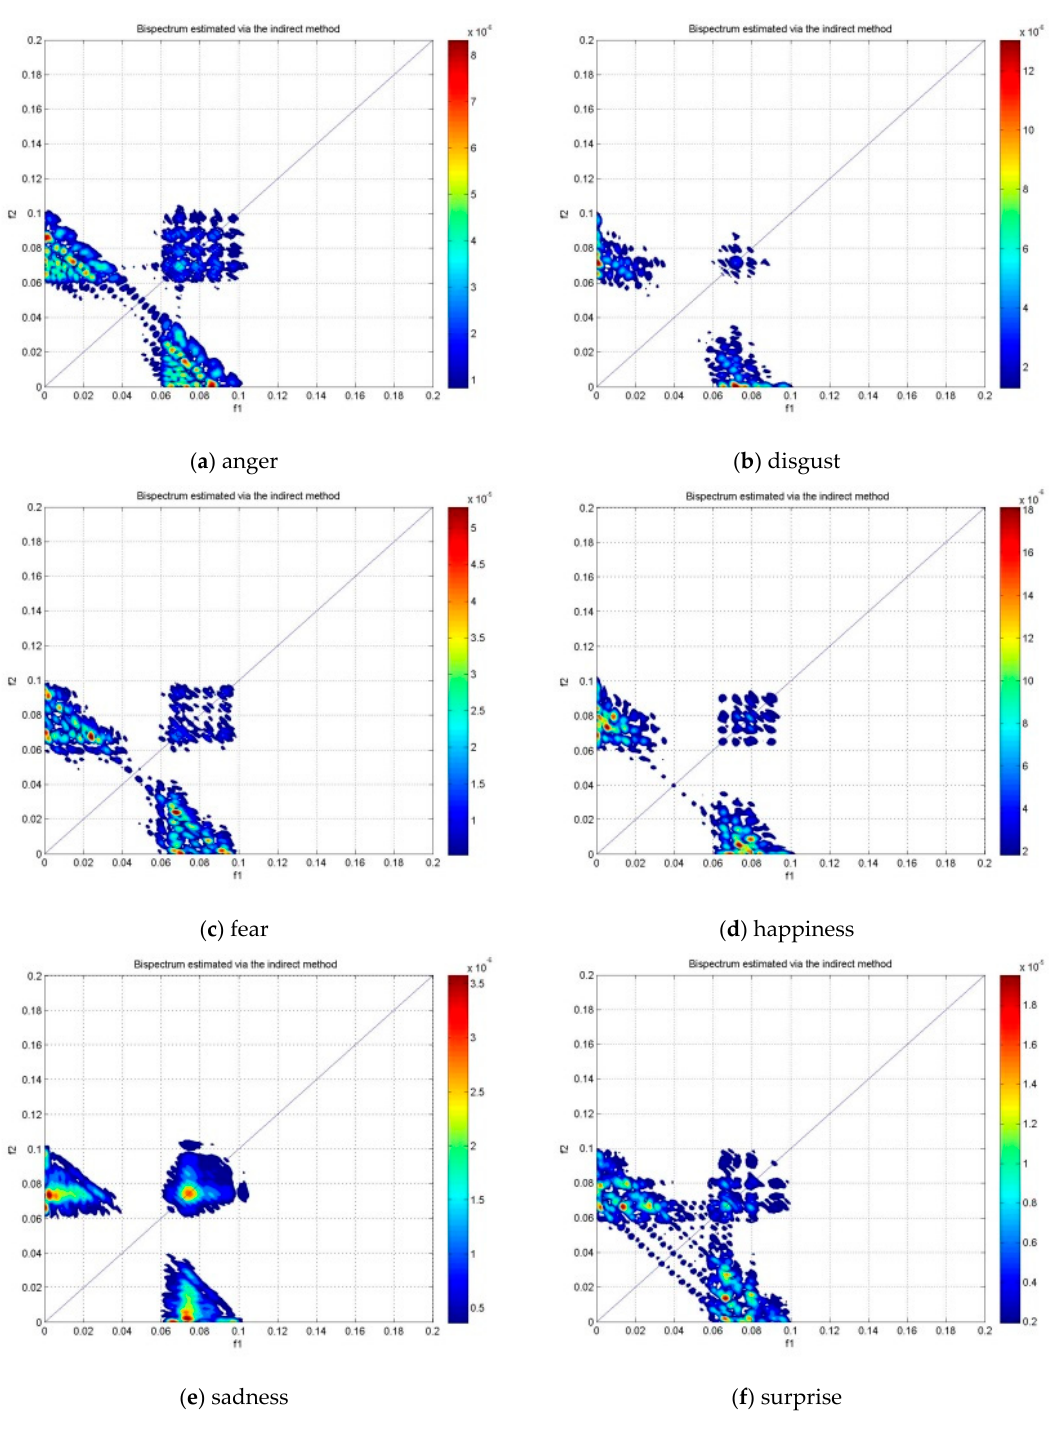
Figure 6. The bispectrum contour plot of the non-redundant region and one symmetry region in the alpha band of subject #1 LBD group.